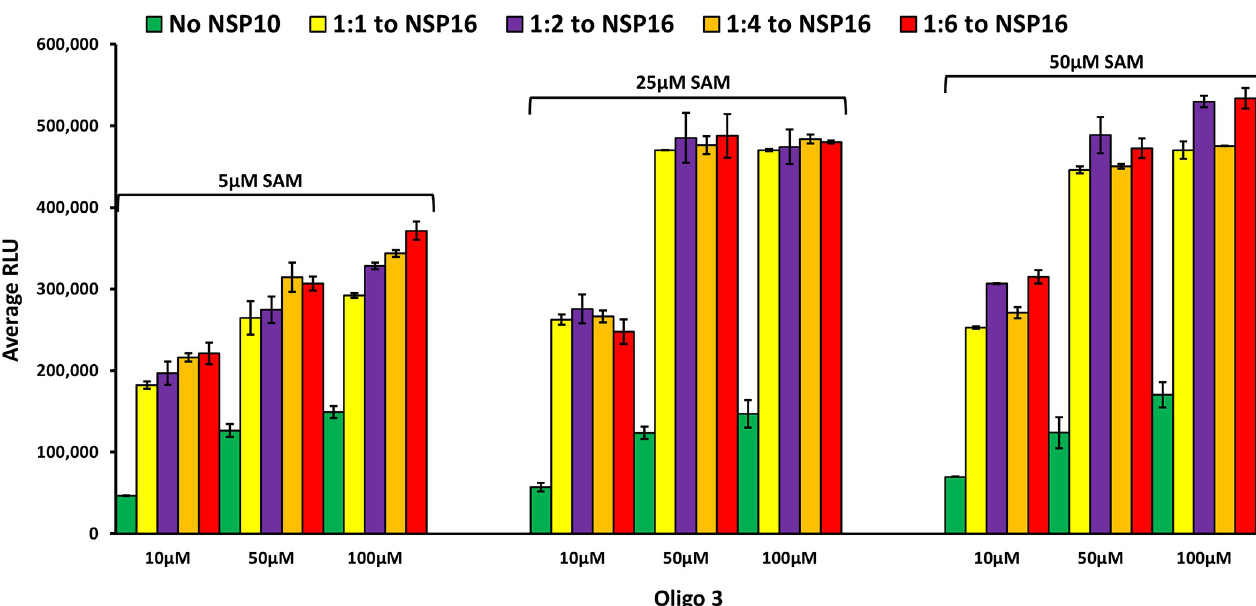
Fig 5. Determining optimal stoichiometry of SARS-COV-2 nsp10 & nsp16 MTases. Monitoring methyltransferase activity of nsp10/nsp16 starting with constant concentration of nsp10 (0.5 μ M) and increasing ratio of nsp16 (0, 1:1, 1:2, 1:4, and 1:6) in the presence of 5, 25, and 50 μ M SAM and different concentrations of Oligo 3 (10, 50, and 100 μ M). Reactions were carried out in white solid low volume 384-well plate for 90min at 37˚C. The MTase-Glo ™ Assay was performed as described in Method and Materials. Each point represents an average of three data points; the error bars represent the standard deviation Data analysis was performed with Microsoft 1 Excel 2013